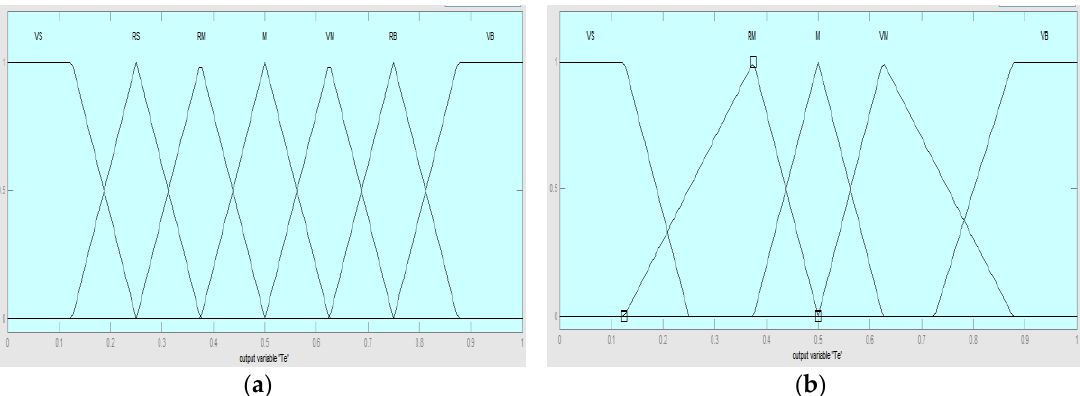
Figure 12. Optimized engine torque membership function for driving condition blocks: ( a ) Block ② ; ( b ) Block ④ .